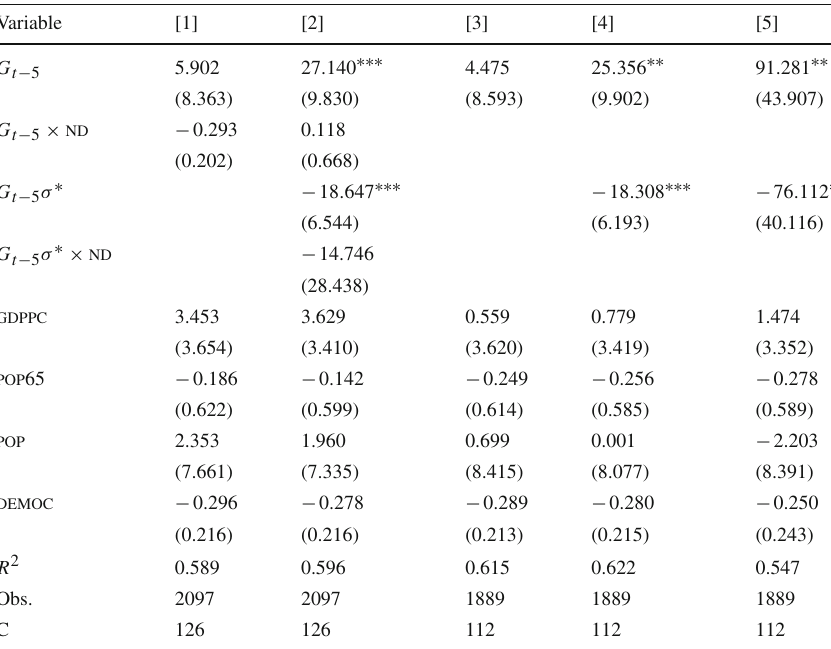
Table 2 The relation between τ , σ ∗ and G in democracies